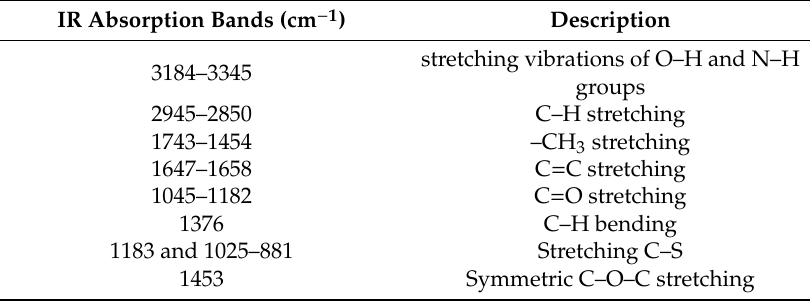
Figure 5. FTIR spectra of PEDOT:PSS coated ( a ) PP, ( b ) PLA and ( c ) blend PP/PLA yarn. Table 1. FTIR transmittance bonds of thermoplastic yarns.